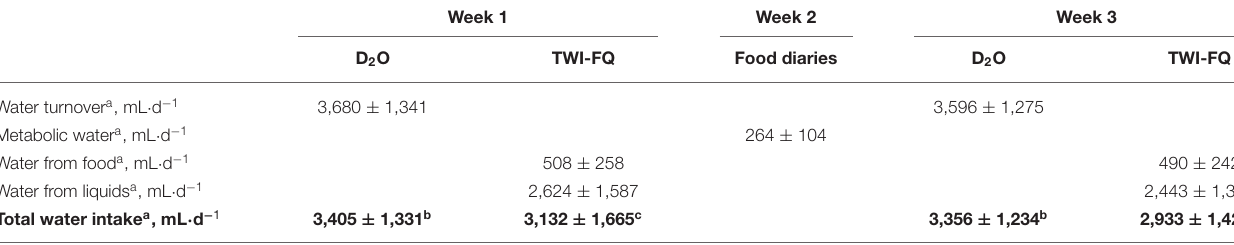
TABLE 2 | Mean daily water turnover and mean daily water intake by week and method.